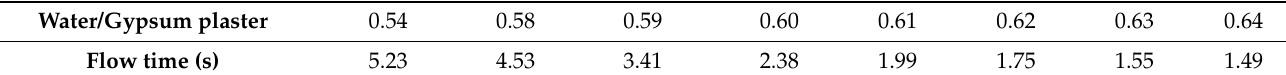
Table 3. Results of flow time measurements test.